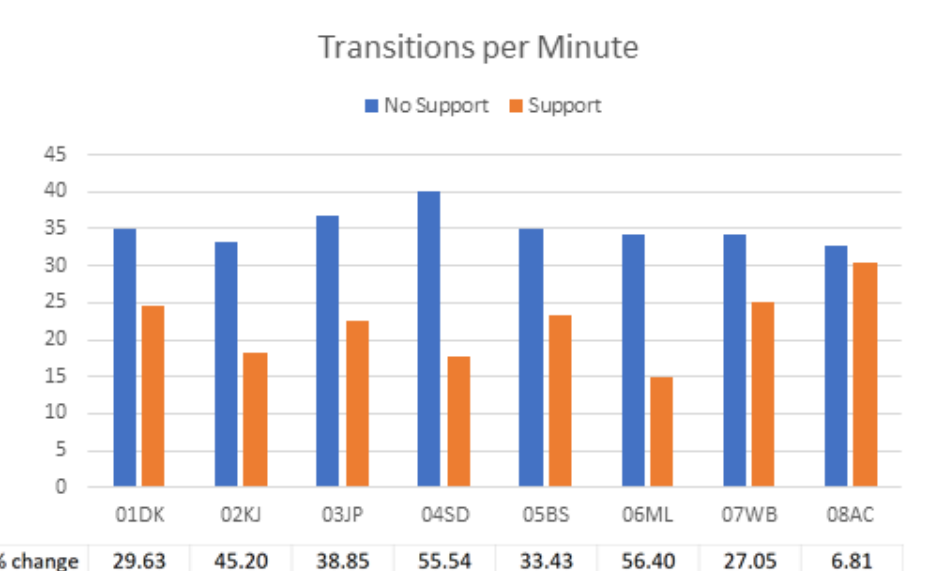
Figure 9. A comparison of the number of transitions per minute for each child in the unsupported and supported conditions. Each child reduced the number of transitions per minute when support was